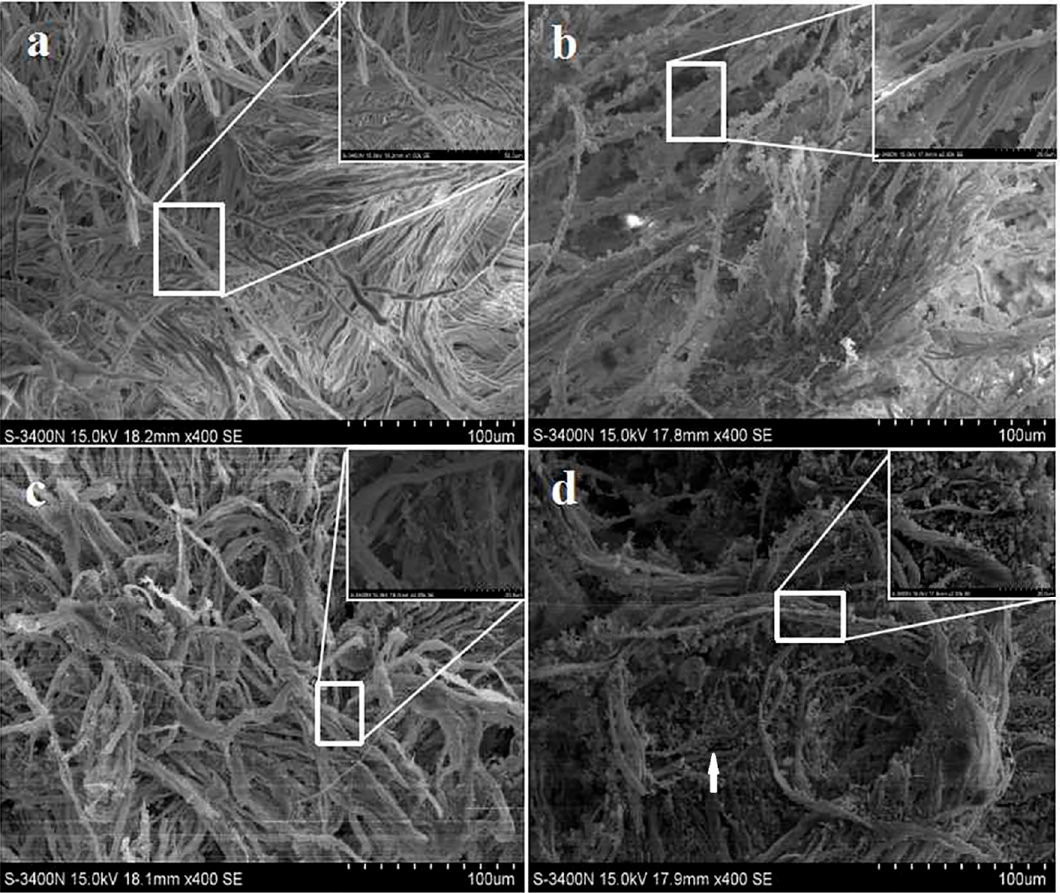
Figure 4. SEM images of modified SiO 2 nanospheres leather without a cross-linking agent: ( a ) blank leather, ( b ) APTES-modified, ( c ) MPTES-modified, and ( d ) GPTES-modified SiO 2 nanospheres leather.